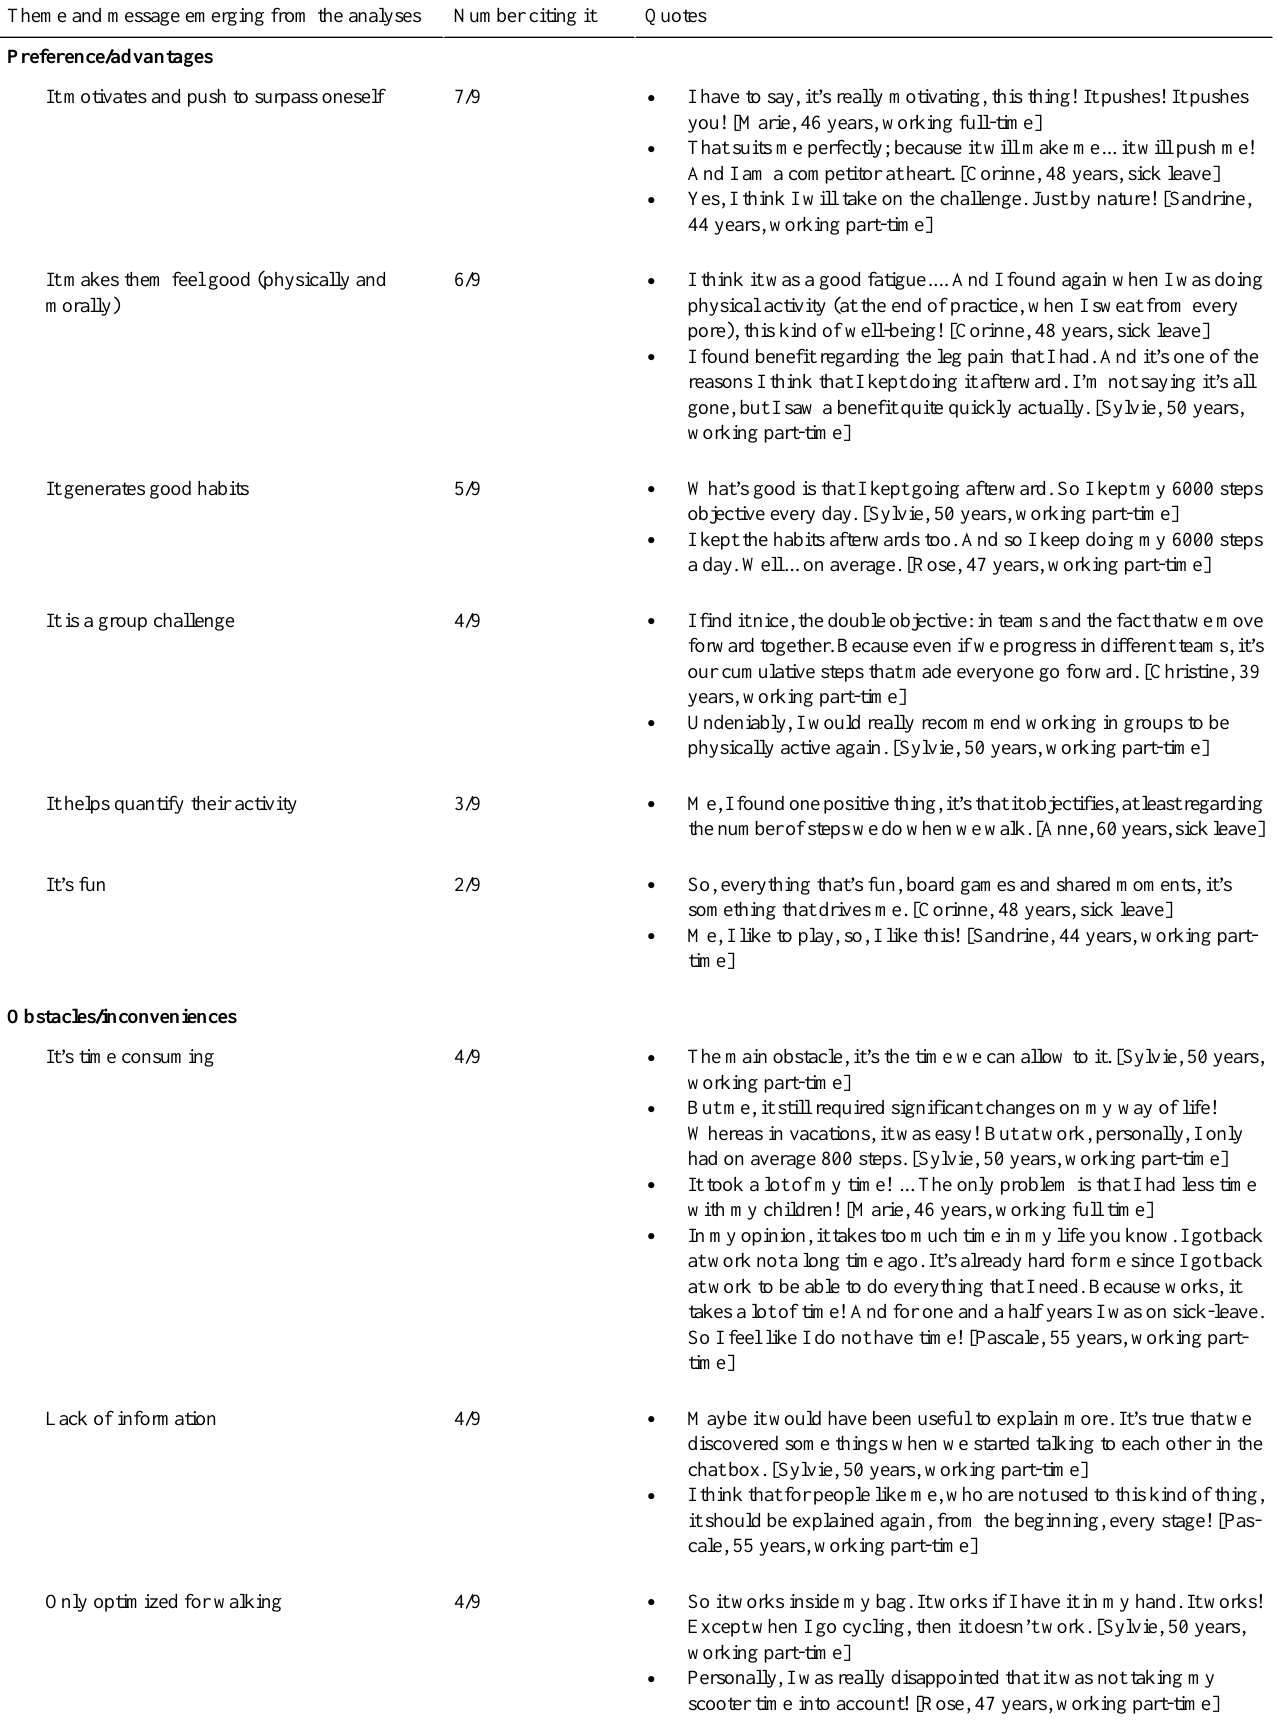
Table 3. Opinion about Kiplin mHealth group challenge.